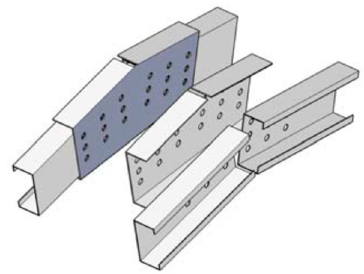
Figure 4. Details of apex joint.